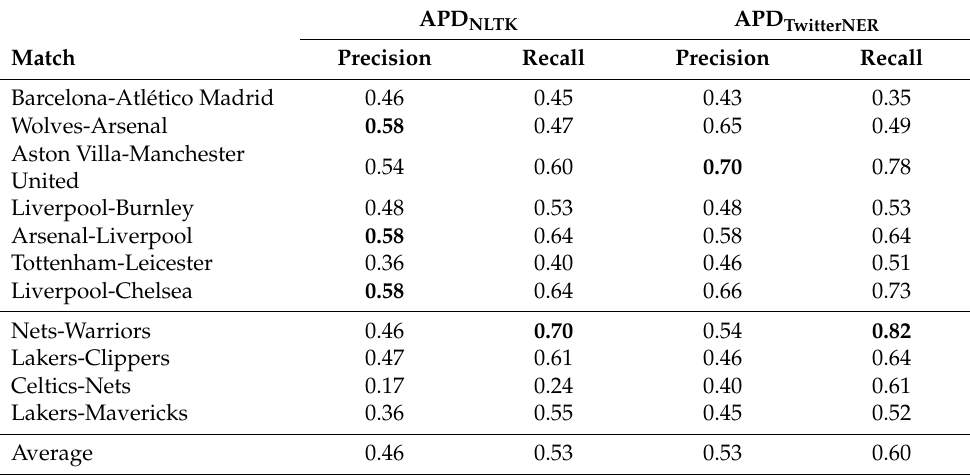
0.10 Lakers-Mavericks 0.16 Average Table 3. The precision and recall of our APD approaches’ final rankings after extrapolation. APD NLTK APD TwitterNER Match Precision Recall Precision